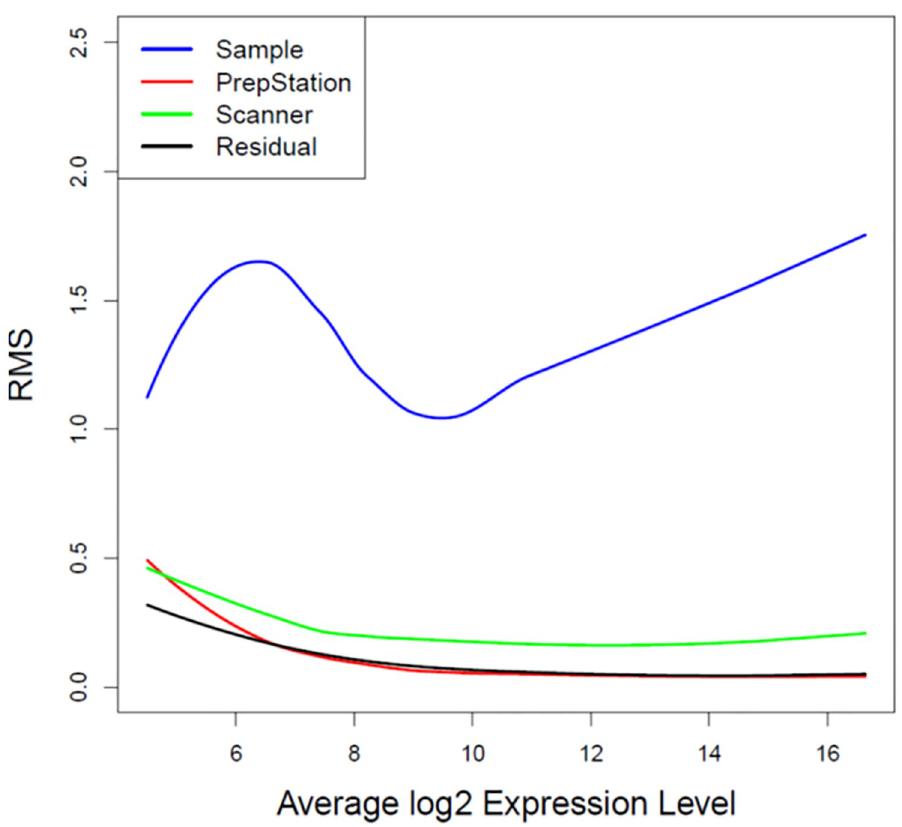
Fig 3. LOESS curve fitting of RMS against average expression levels for the comparison at the first time scan. Variance components of ANOVA models were smoothed over average log2 expression levels through the LOESS fit. Blue curve represents variability of biological samples. Red curve represents variability of PrepStation. Green curve represents variability of scanners. Black curve represents variability of residual errors.